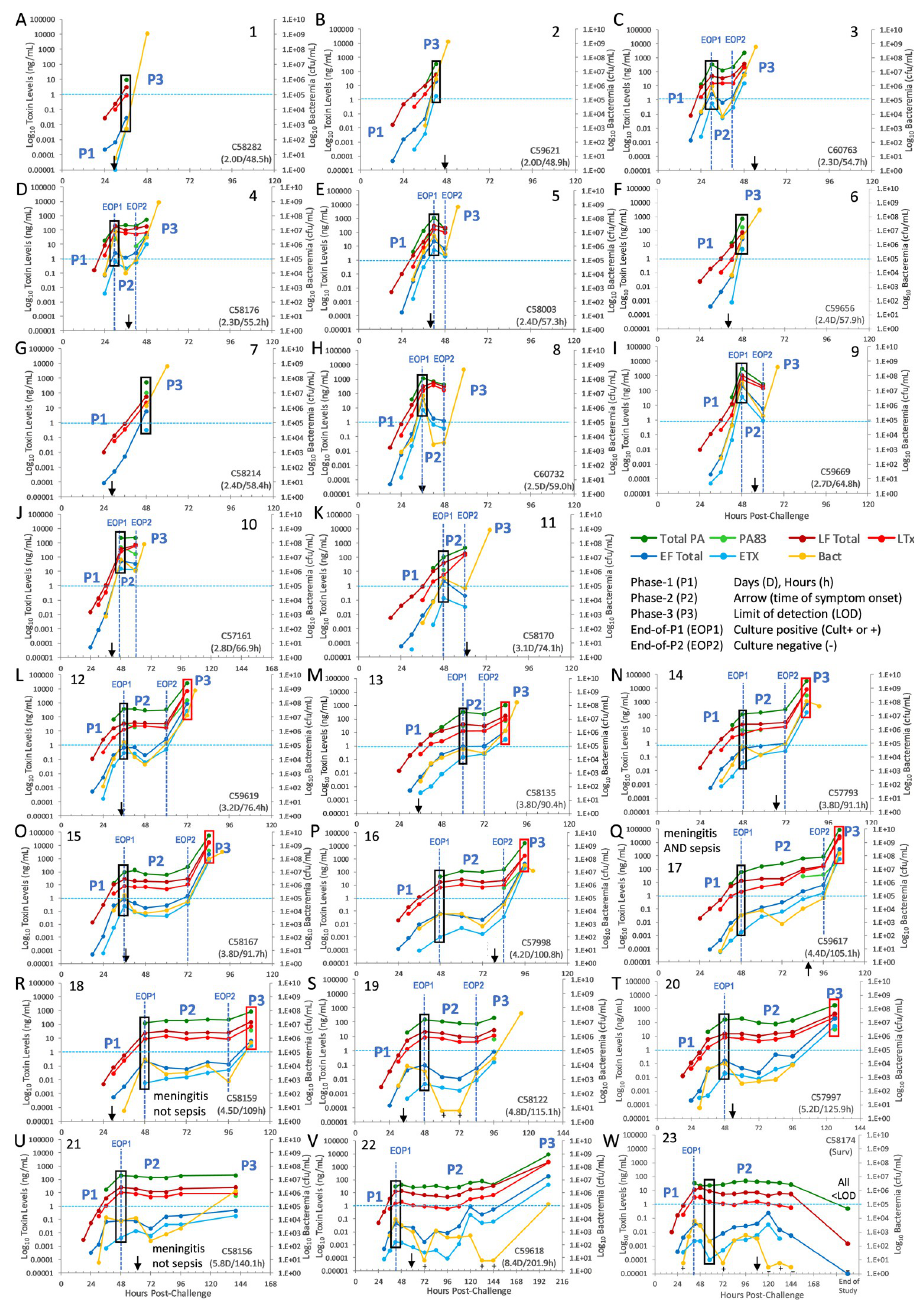
Fig 3. Anthrax toxins and bacteremia during inhalation anthrax in individual cynomolgus macaques. Total PA, PA83, LF, EF, LTx and ETx (ng/mL) and bacteremia (cfu/mL) in 11 animals with fast progression (A-K), 11 with slow progression (L-V), and the survivor (W). Phase-1 (P1), phase-2 (P2) and phase-3 (P3) are indicated when present. Blue vertical dashed lines indicate the point separating the phases; the end-of-P1 (EOP1) that ends the P1 rise and begins the P2 plateau and the end-of-P2 (EOP2) that ends P2 and begins P3. Black arrows indicate the time of symptom onset. Survival time-days (D), hours (h). Black rectangles at the end-of-phase-1 show how toxin levels are convergent (lower differences between highest toxin PA and lowest toxin ETx) in animals with shorter survival or divergent (higher differences between PA and ETx) in animals with longer survival. Red rectangles in phase-3 in animals with longer survival show convergent levels at terminal infection. Toxins (ng/mL) and bacteremia (cfu/mL) were graphed on a similar scale (10-orders of magnitude) for comparison of dynamic changes, orders of magnitude. Aqua horizontal dashed line at 1 ng/mL toxin concentration and 1.0E+05 cfu/mL bacteremia. Low positive culture (+) graphed at 6 cfu/ mL and negative culture (-) at 3 cfu/mL. Less than the limit of detection ( <